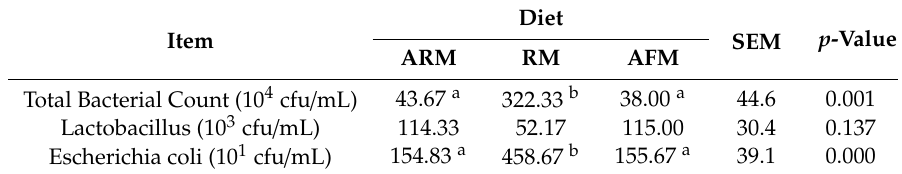
Table 2. Bacterial numbers of di ff erent types of milk. Item